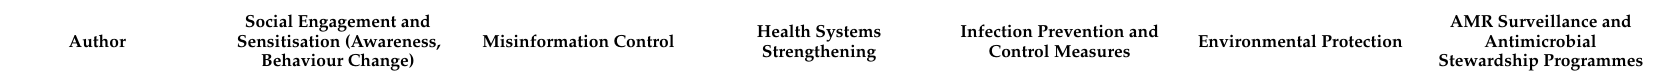
Table A1. Mitigation strategies suggested by the reviewed